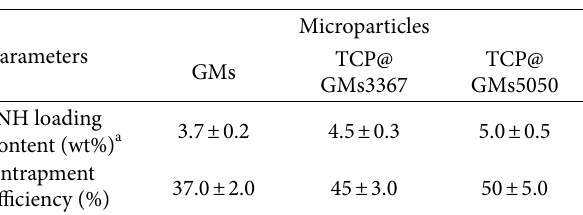
Table 1: INH loading content and entrapment efficiency of GMs and TCP@GMs microparticles.